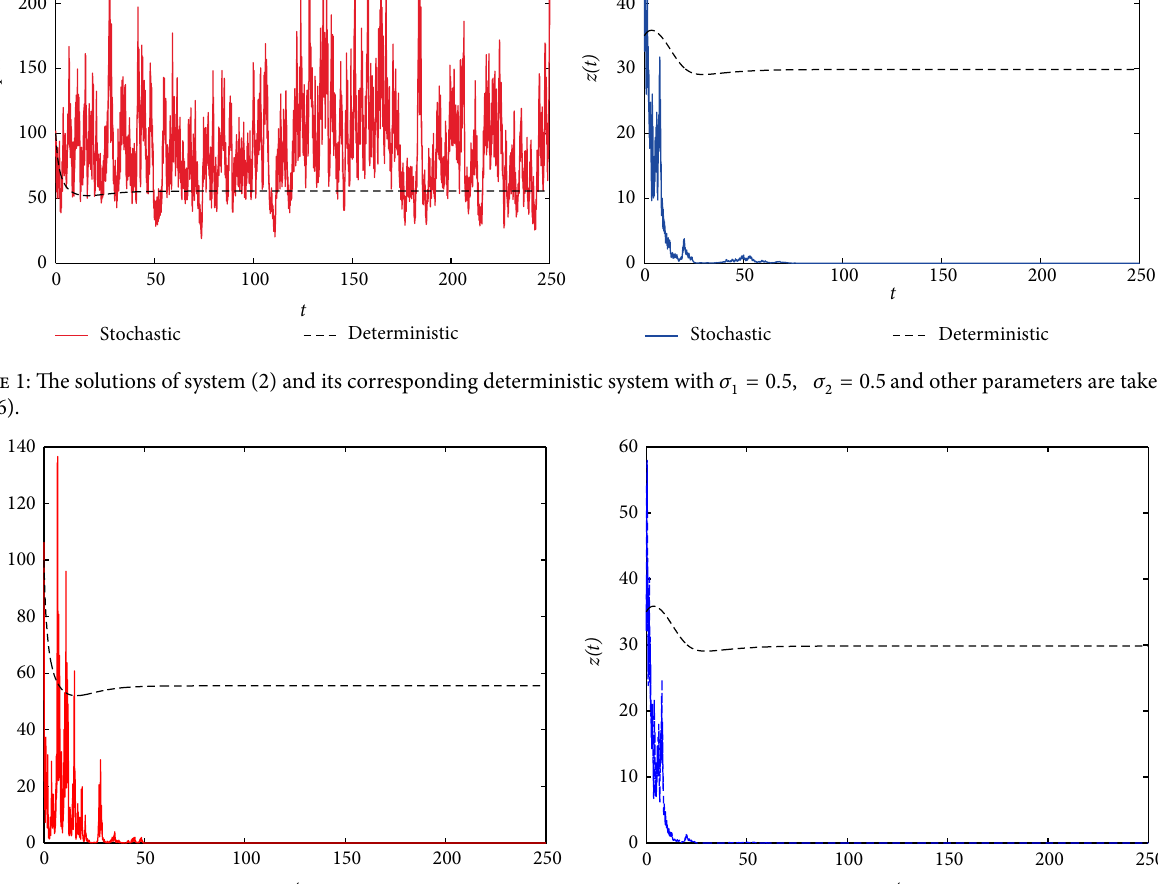
Figure 2: The solutions of system (2) and its corresponding deterministic system with 𝜎 Eq. (76).